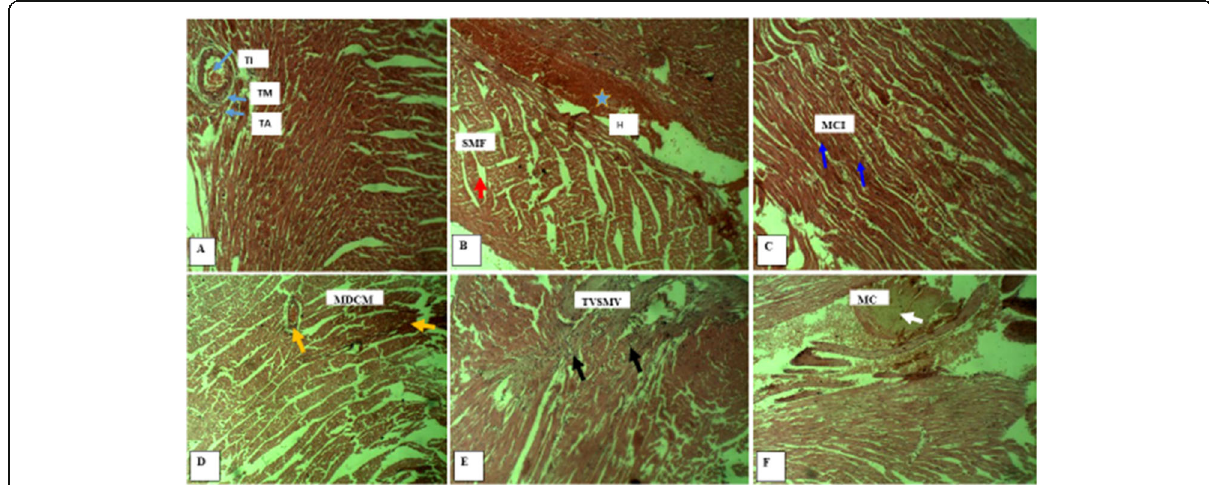
Fig. 1 a – f Histoarchitectural structure of the heart tissue as shown in the pre-treatment groups. a Normal control, b Dox only (positive